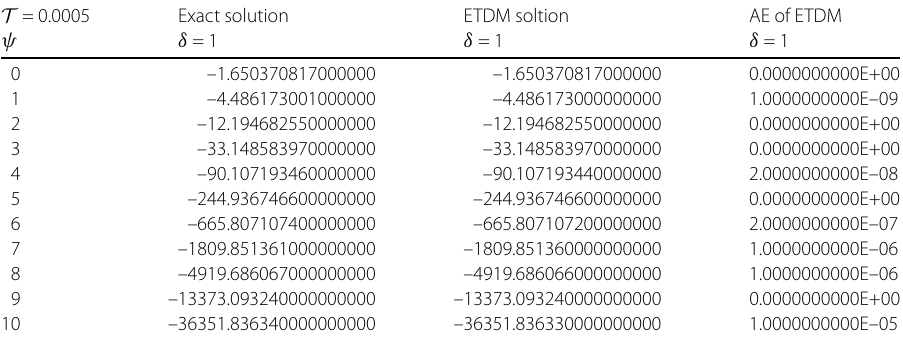
Table 3 μ ( ψ , ζ , T ) Comparison of Exact solution, ETDM and ETDM Error of example 1 at ρ = 1 T = 0.0005